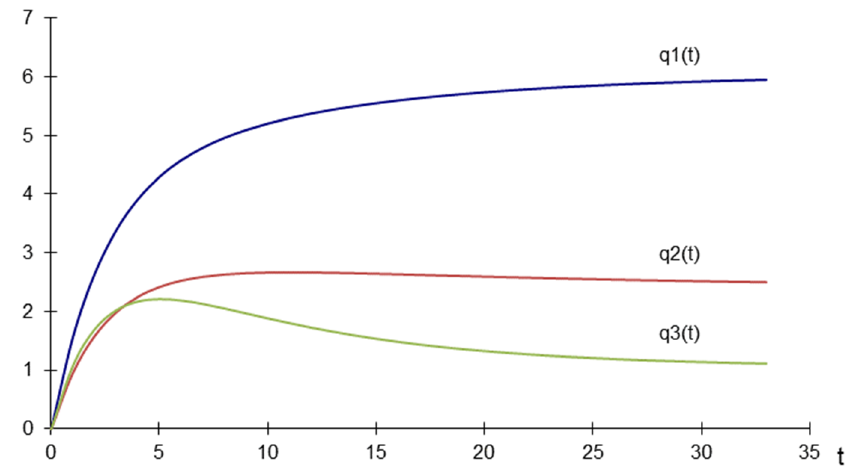
Figure 2. Equilibrium quantities for adaptive expectations—dynamic map.